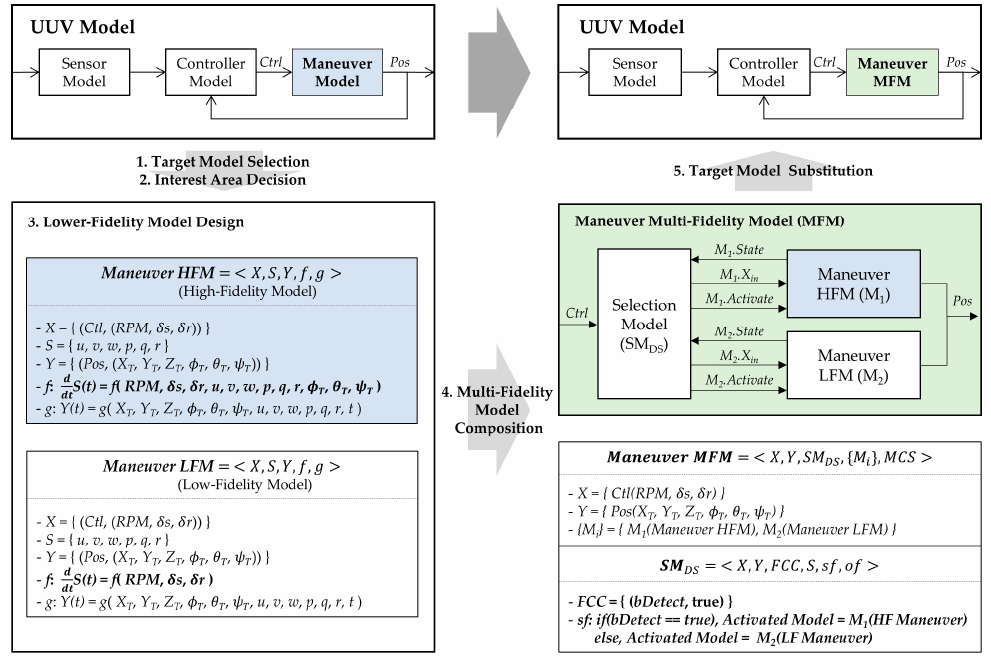
Figure 14. The overall process of the multi-fidelity modeling framework: UUV tracking simulation as an example of dynamic systems.